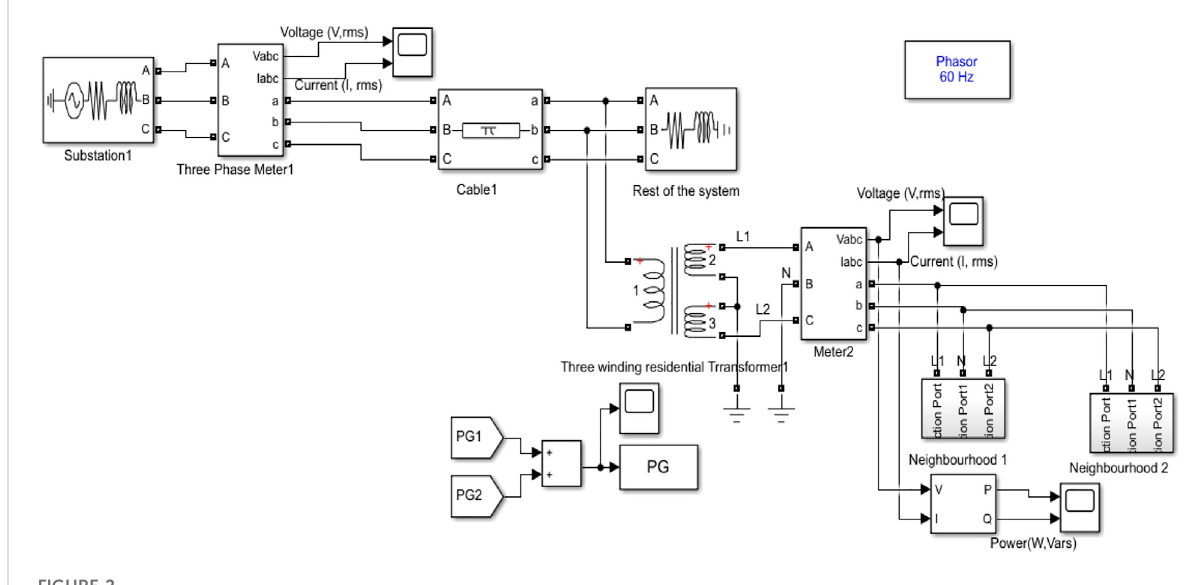
FIGURE 2 Schematic representation of a data-driven smart grid system for incorporating a DR program.